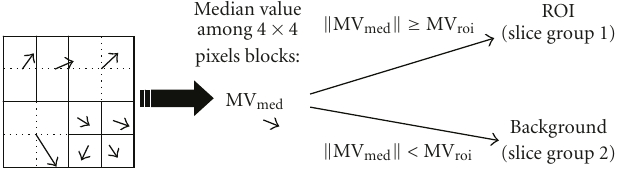
Figure 2: Macroblock classification according to the motion vector value.